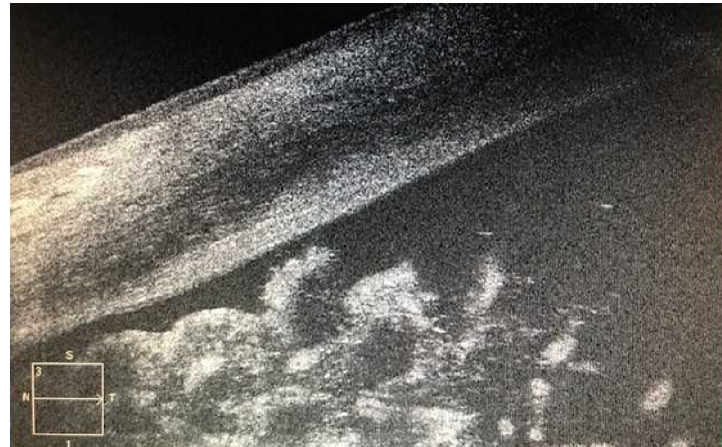
Figure 1: Frayed iris segments blocking the angle view (anterior segment scan, Cirrus HD-OCT, Carl Zeiss Meditec, Dublin,